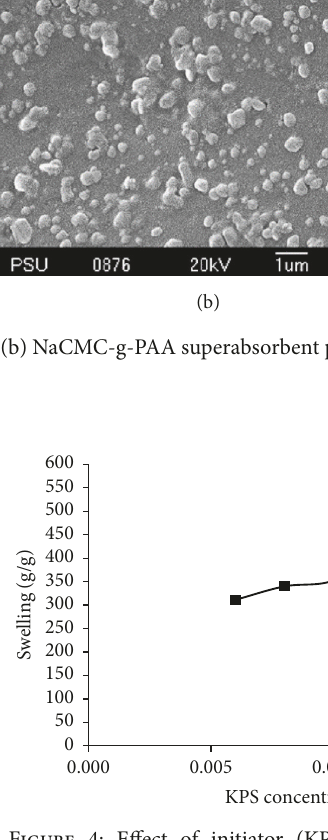
Figure 4: Effect of initiator (KPS) concentration on swelling capacity (reaction condition: 2.0 g/100 mL NaCMC, 0.8 mol/L AA, 70% neutralized AA, and 0.01 mol/L MBA at 70 ∘ C for 90